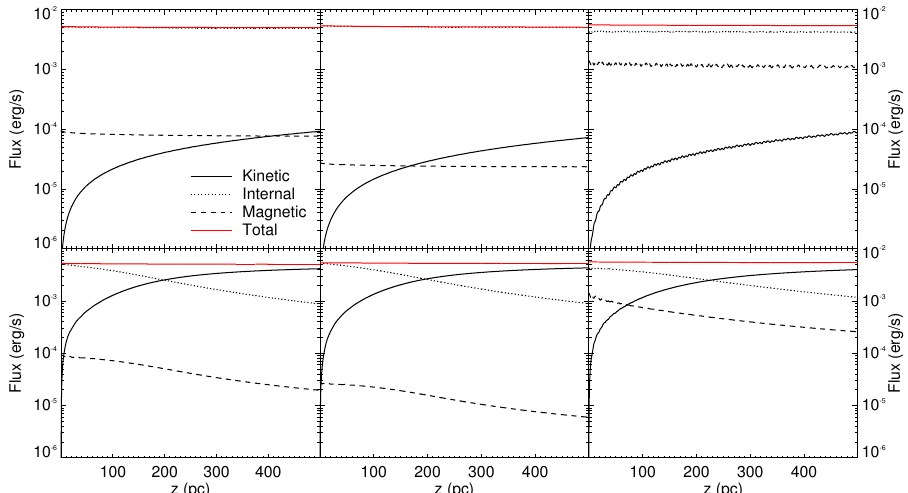
Figure 11. Evolution of the energy fluxes (in logarithmic scale) for steady-state, axisymmetric jet simulations for hot dilute, magnetized jets mildly (mean stellar mass-loss ˙ M w = 10 − 11 M (cid:12) /yr, upper panels) and strongly mass-loaded ( ˙ M w = 10 − 9 M (cid:12) /yr, lower panels). The jets also differ in the initial Lorentz factors 10 (left and right) and 6 (centre), and mean pitch angle (defined as tan − 1 ( B φ / B z ) ) of 45 ◦ (left and centre) and 75 ◦ (right). The red line indicates the total flux, the dotted line stands the internal energy flux, the solid line the kinetic energy flux and the dashed line the magnetic energy flux. Perucho et al. (in